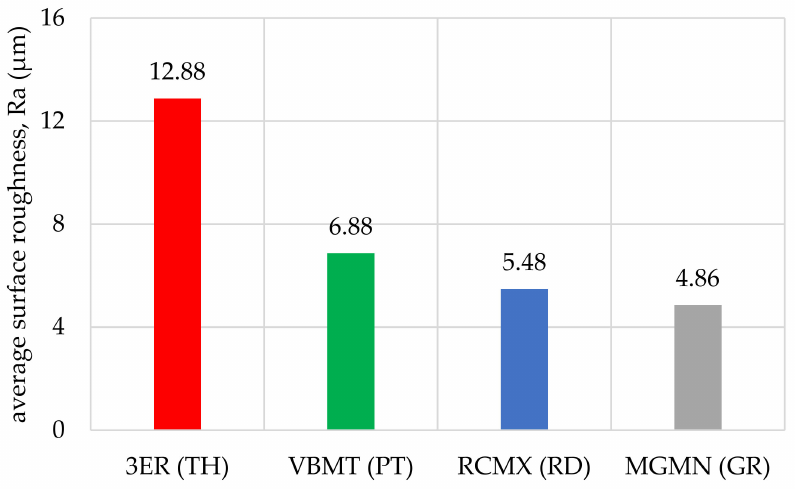
Figure 12. Average surface roughness R a obtained in all tests depending on the insert used. The obtained values of mean roughness depth R z are shown in Figure 13 and in Table 3. Average surface roughness obtained in all tests depending on the cutting depth is shown in Figure 14. It was also determined that the quotient Rz to Ra depends on the type of insert and wood species. Their values are shown in Table 4 as well as in Figure 15. The sample macroscopic views of the surface after turning of a depth of 1.0 mm are shown in Figure 16. The macroscopic views of the surface of Pinewood after turning with 3ER (TH) with different depths are shown in Figure 17. The macroscopic views of the surface of West African Ebony after turning with 3ER (TH) with the differed depths as well as with the marked distance between successive depressions on the structure are shown in Figures 18 and 19. Table 3. The R z values obtained in the tests depend on the type of insert and wood species. Species of